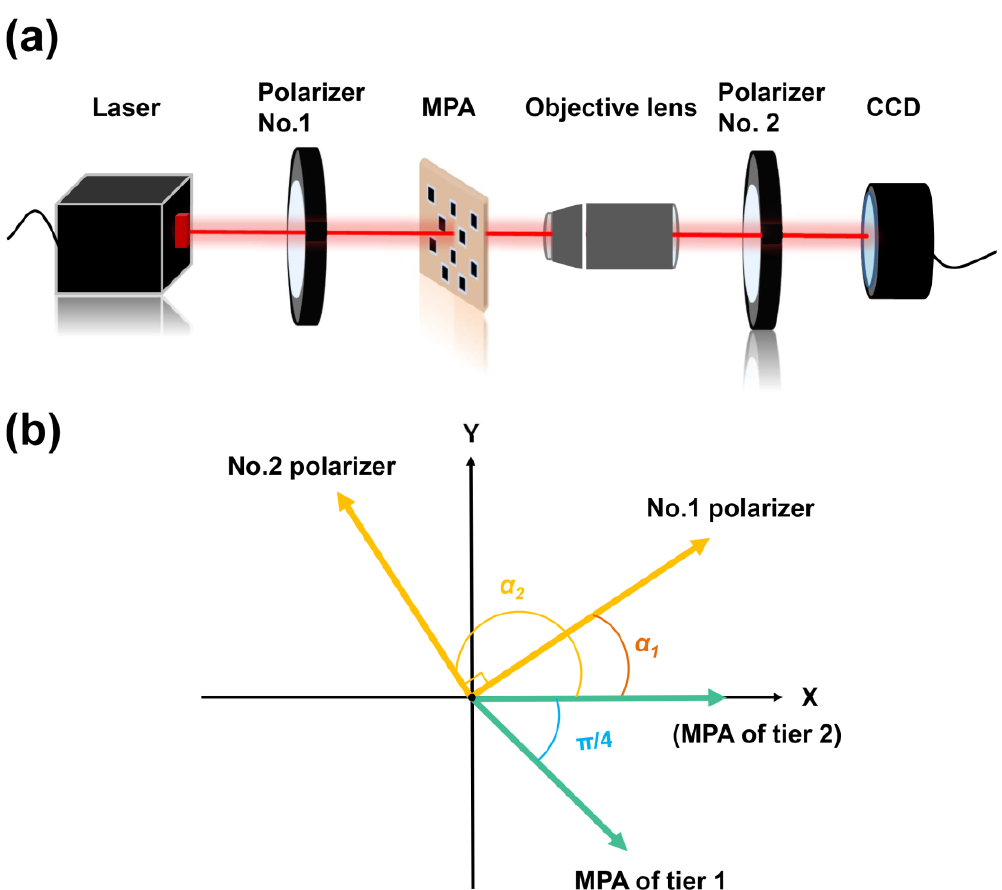
Figure 4. ( a ) Schematic diagram of the dark-field measuring system for MPA polarization property measurement. ( b ) The relative positions of the polarizing angle of MPA and polarizers in the same coordinate.